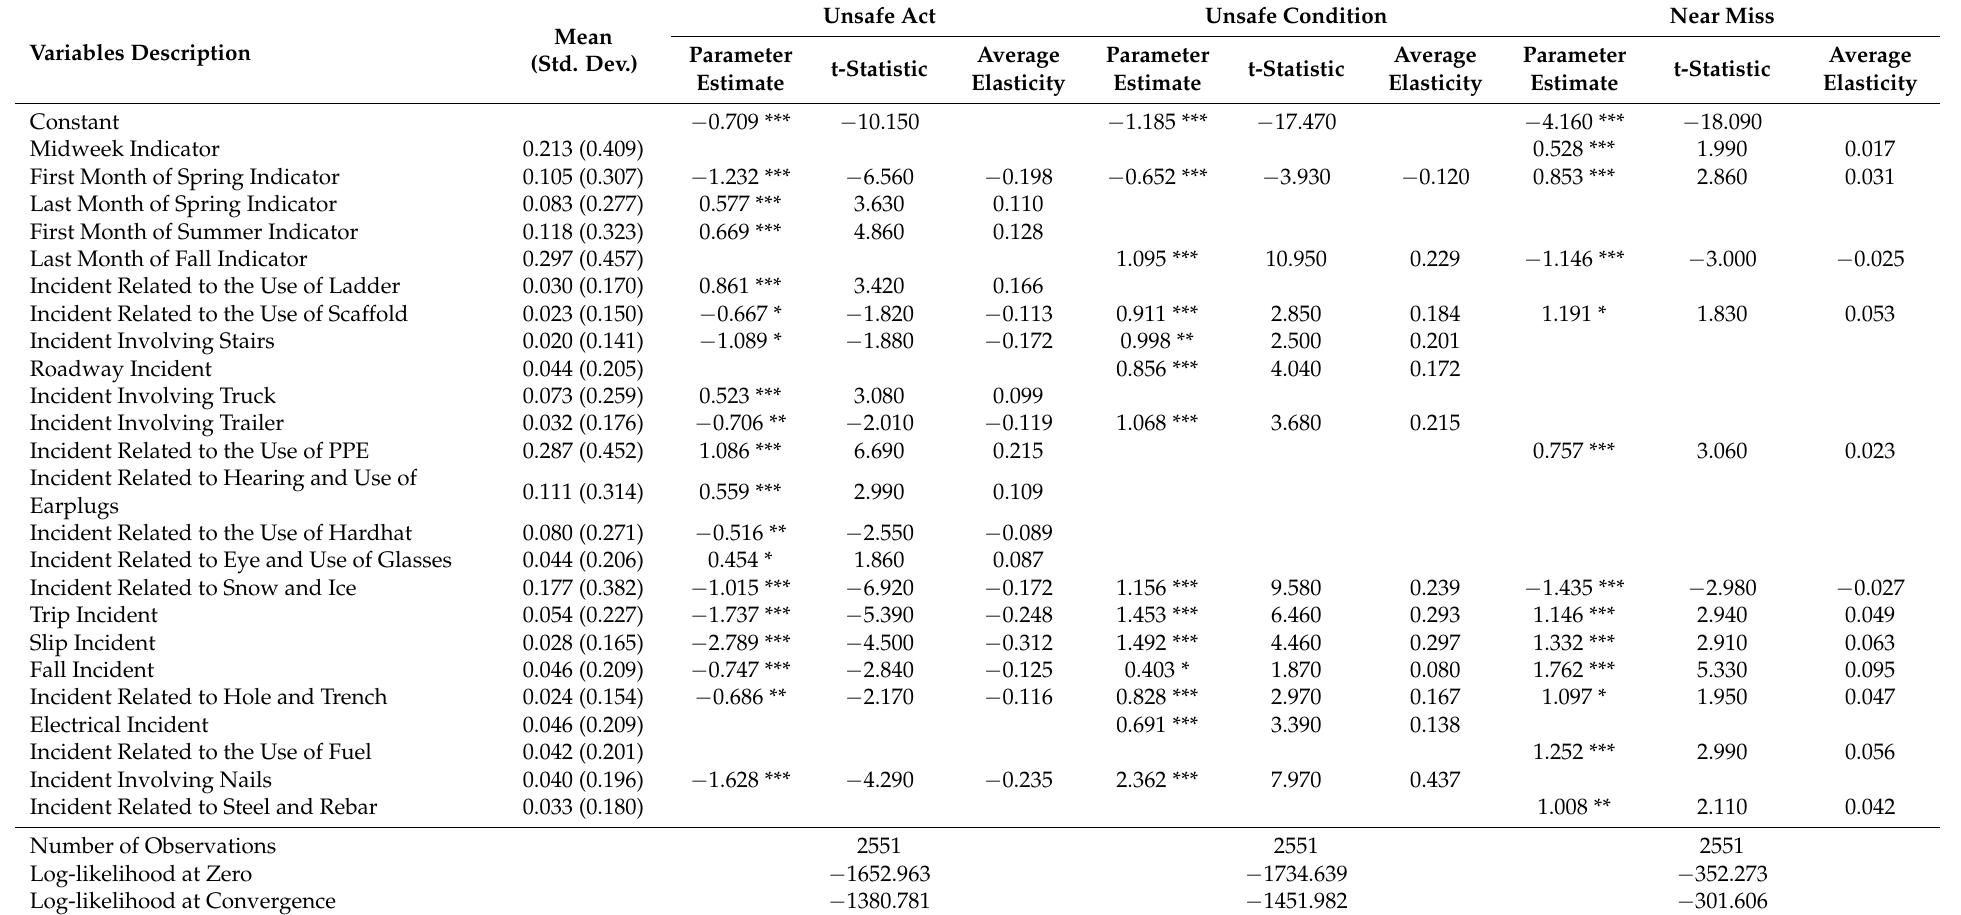
Table 2. Model estimation results and elasticity estimates for unsafe act, unsafe conditions, and near